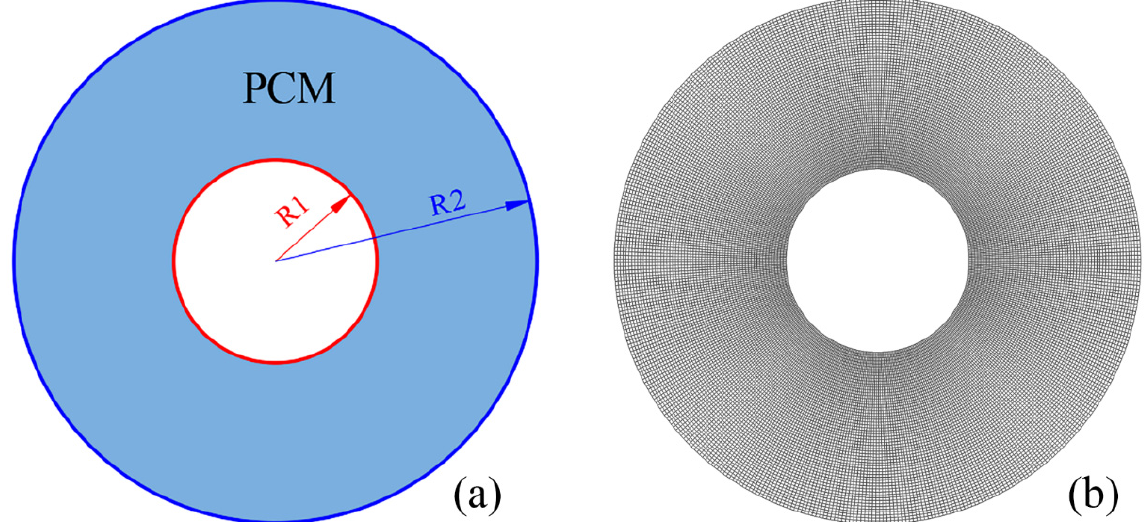
Figure 2. Geometry ( a ) and computational mesh ( b ) for the tubular phase change material thermal energy storage unit.